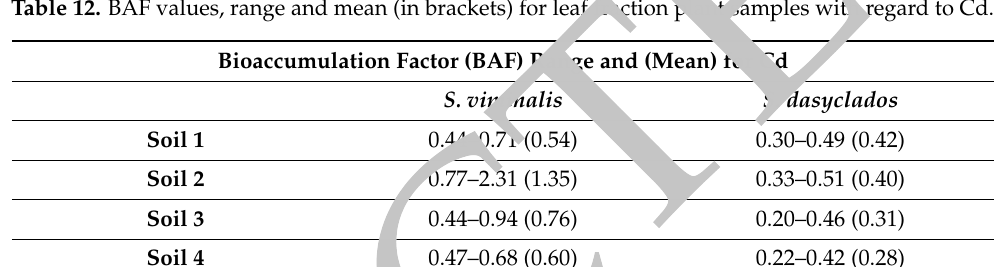
Table 12. BAF values, range and mean (in brackets) for leaf fraction plant samples with regard to Cd. Bioaccumulation Factor (BAF) Range and (Mean) for Cd